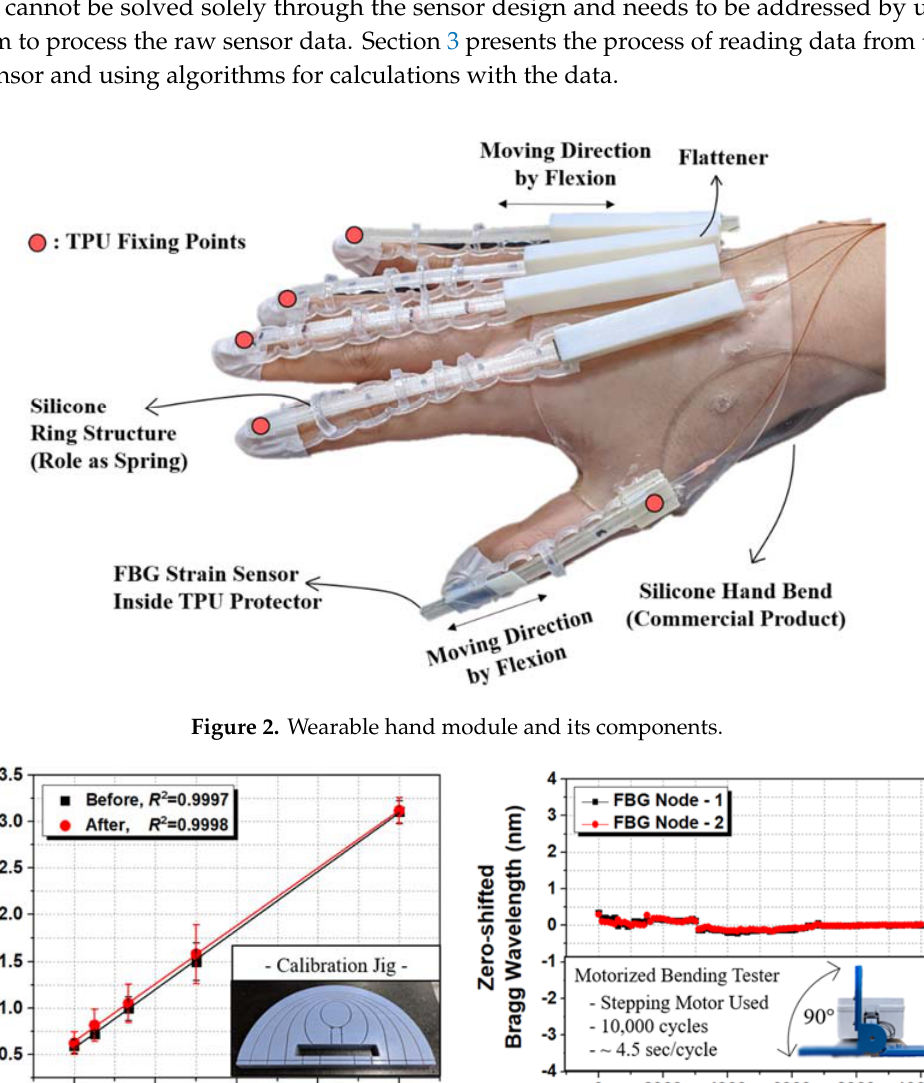
Figure 4. Schematic diagram of the FBG interrogation system for real ‐ time tracking of the finger joint angle. To calculate the algorithm, Bragg wavelength data are sent from the smart fiber interrogator to a PC via User Datagram Protocol (UDP) communication. A tracking algorithm in the Microsoft Foundation Class (MFC) ‐ based program translates the Bragg wavelength data into the angle for each joint of the finger. The algorithm calculates the change in the Bragg wavelength of the FBG nodes attached to the wearable hand module every 10 ms within the thread function. The buttons in the dialog box are used to select one algorithm and track the finger joint within 20–40 ms. Before the algorithm can be performed, the reference data for the finger joint angles when the user’s fist is clenched need to be entered. The required reference data are the angles of the MCP, PIP,